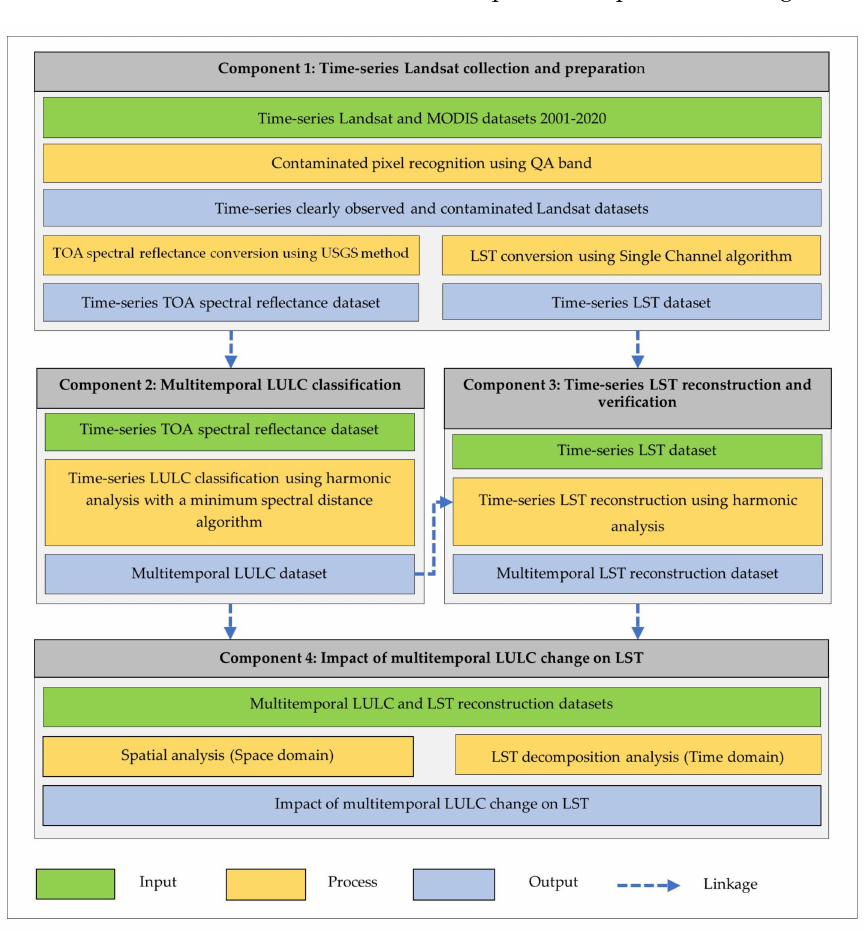
Figure 3. Workflow and connections of research methodology